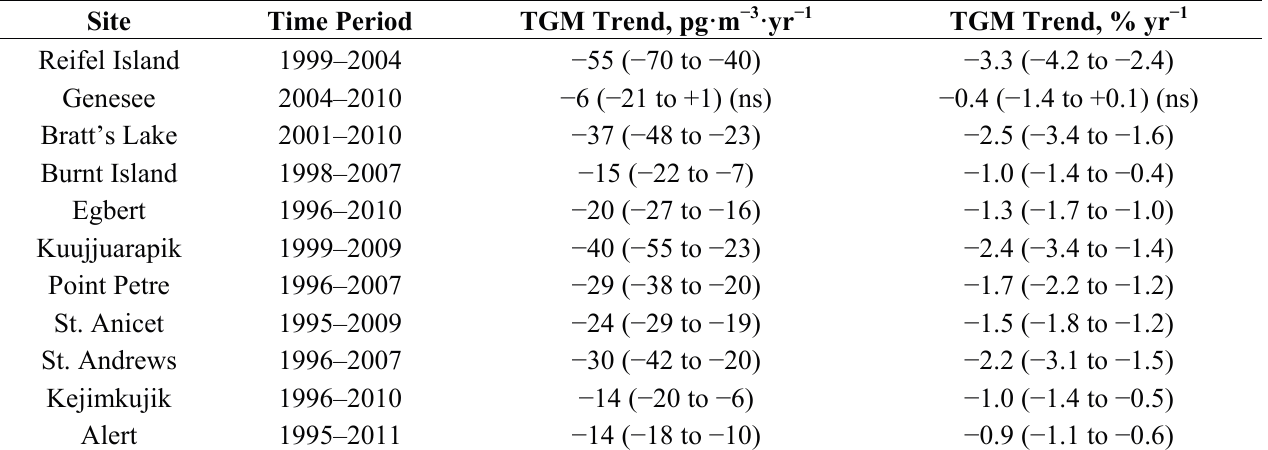
Figure 10. An overall decreasing trend of − 0.055 ng·m − 3 ·yr − 1 or − 55 pg·m − 3 ·yr − 1 was determined at Reifel Island from five years of data. To illustrate the result, the time series of monthly median TGM